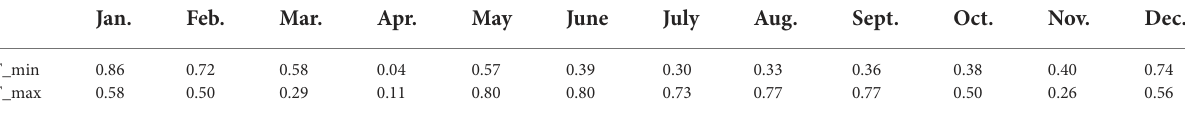
TABLE 1 R-squaredofdailypeakloadvsdailyminimumandmaximumtemperature.